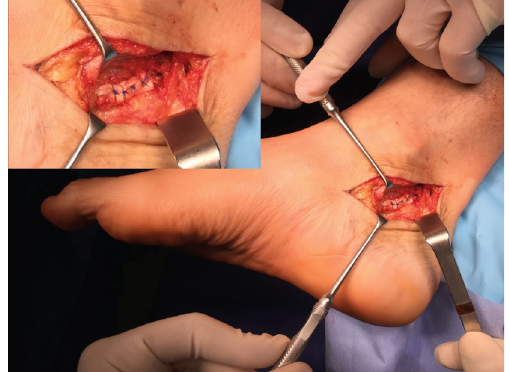
Figure 4: De fi nitive suture of the fl exor hallucis longus type pulvertaft.